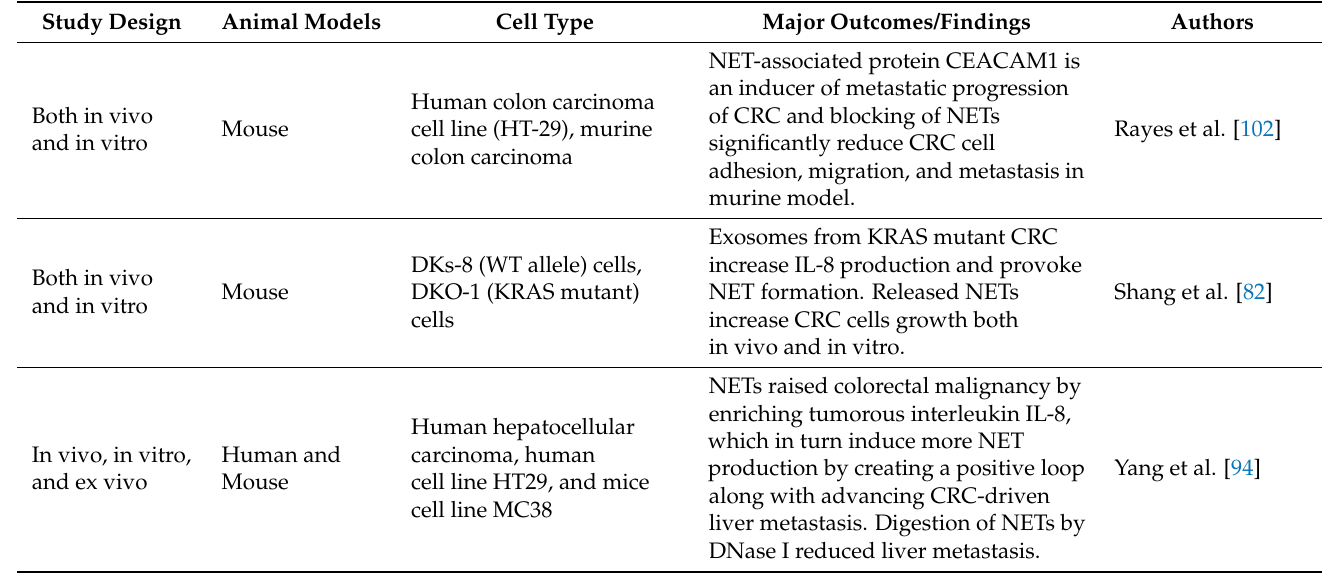
Figure 2. NET-mediated CRC progression and metastasis. KRAS mutation induces colon cancer cells proliferation and migration through the blood vessel. IL-8 secretion by circulating cancer cells or transfer of mutant KRAS to neutrophils via exosomes provoke NET formation in blood vessel of distant organs. Mast cells expressing polyphosphates (polyP) stimulate neutrophils and produce NETs. NETs trap cancer cells in distant organs such as in the liver and lung and thus, help metastatic spread. Spontaneous dissemination of colon cancer cells towards peritoneal wounds or inflammation and subsequent attachment to the inflamed peritoneum promote peritoneal metastases. Table 1. Summary of the included studies of NETs in